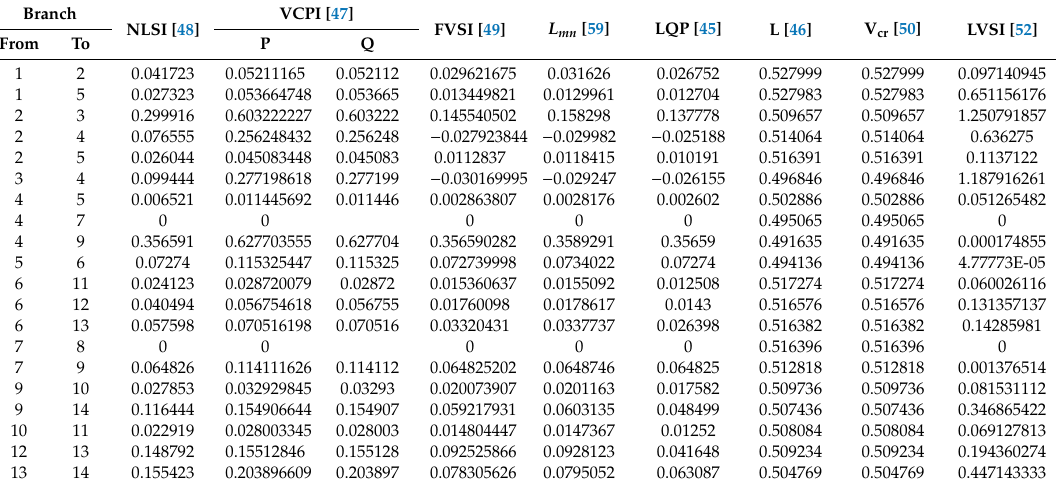
The obtained indices’ magnitude for critical branch identification by each index (IEEE 14-bus